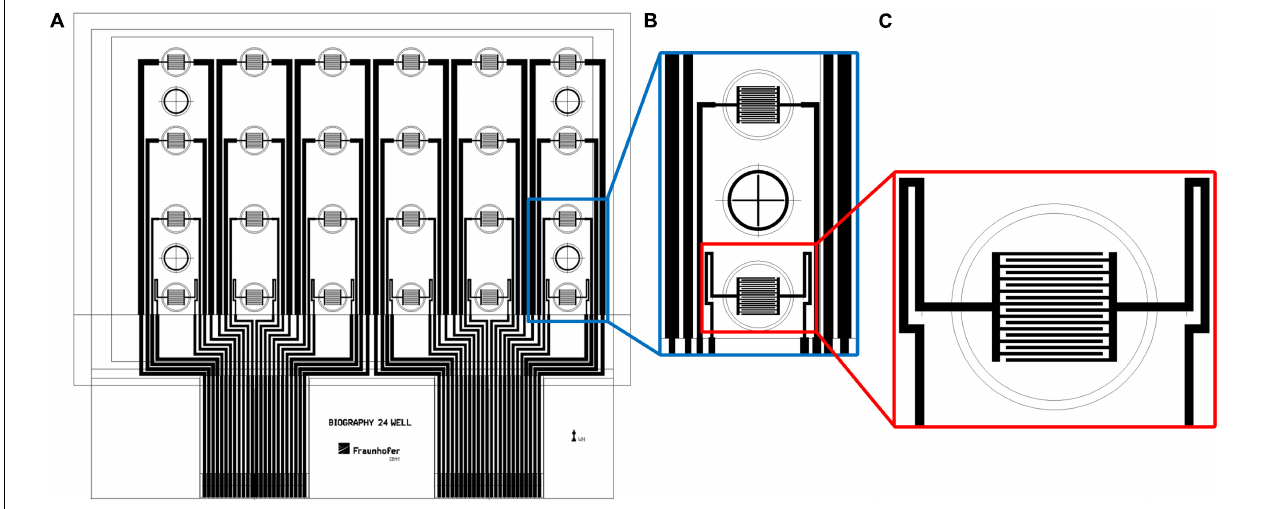
FIGURE 1 | The layout of the biosensor in a well-plate format. (A) Drawing of complete sensor foil in a well-plate format. (B) Interdigitated electrode structures in two wells with one empty well in between. (C) Close-up view of interdigitated electrode structures. Diameter of outer circle: 7